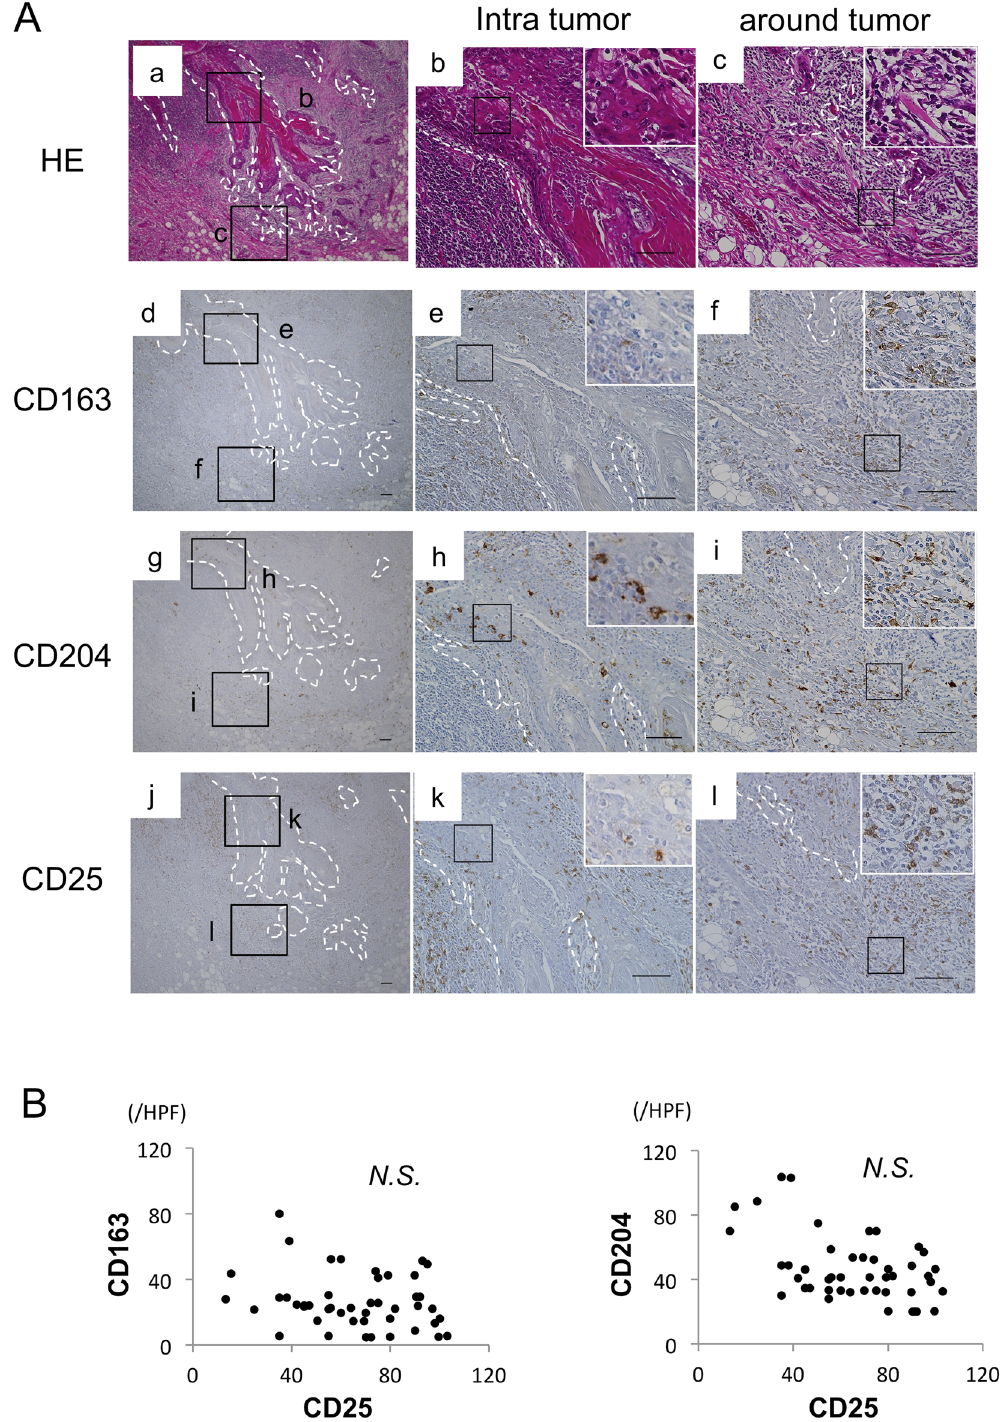
Figure 1. Correlation between tumor-associated macrophages (TAMs) and activated immune cells in OSCC patients. ( A ) Representative images of paraffin sections in/around tumor stained with H&E (a–c), CD25 (j–l), CD163 (d–f) and CD204 (g–i) antibodies (brown). Counterstaining with Mayer’s hematoxylin is shown in blue. Scale bars, 100 μ m. ( B ) Correlation between the number of CD163 + or CD204 + and CD25 + cells in 46 OSCC patients. Statistically significant differences between groups were determined by Spearman’s rank